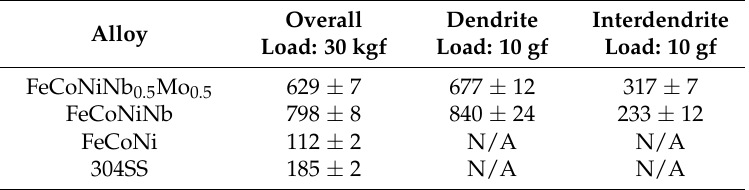
Table 3. Hardness (HV) of FeCoNiNb 0.5 Mo 0.5 , FeCoNiNb, FeCoNi and 304SS